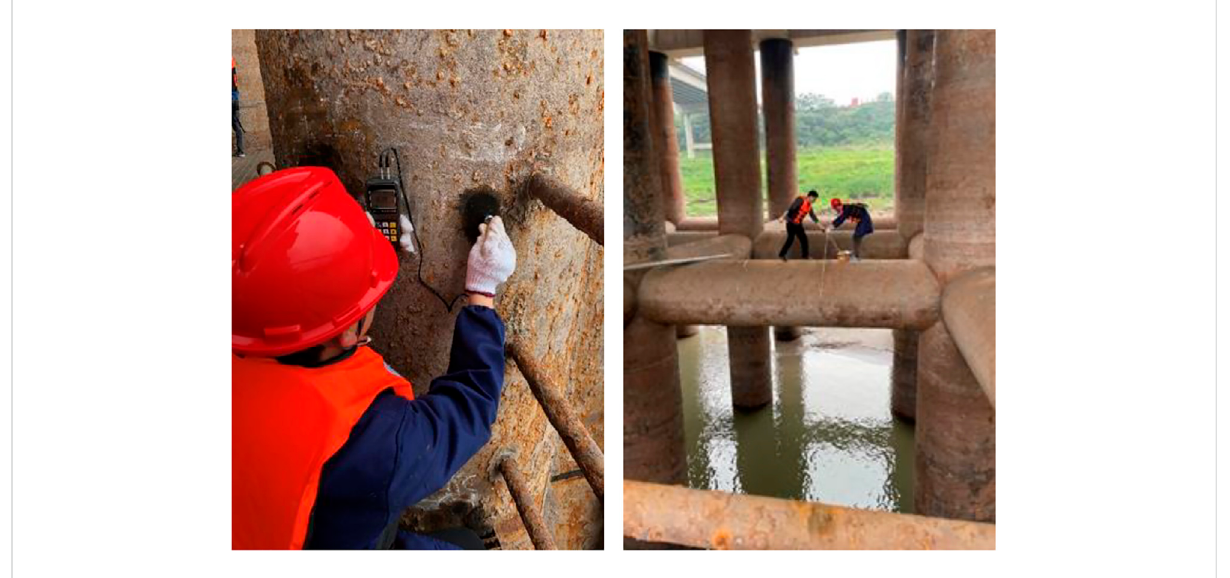
FIGURE 9 Corrosion results for steel components of a certain wharf tested in fi eld.